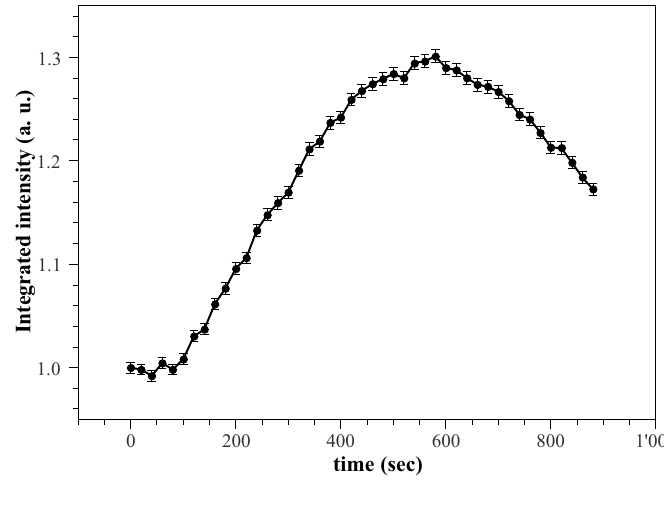
Normalized fluorescence total intensity as a function of time during the enzymatic reaction of the GOD entrapped in the sol gel matrix. Experimental conditions: (cid:21) = 405 nm, (cid:21) according to the passband filter described in the experimental exc em